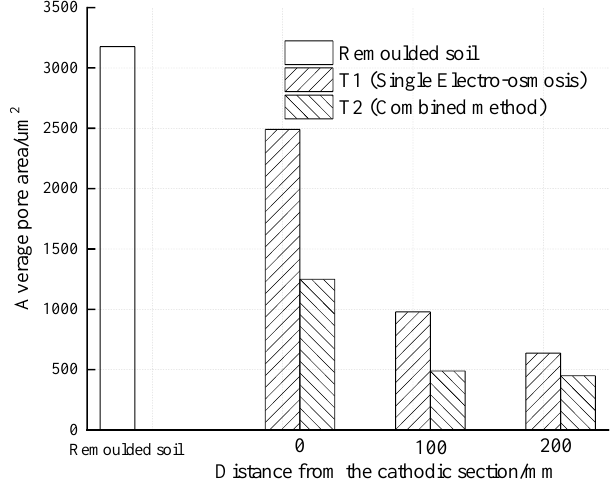
Figure 9. The soil average pore area of T1 and T2.